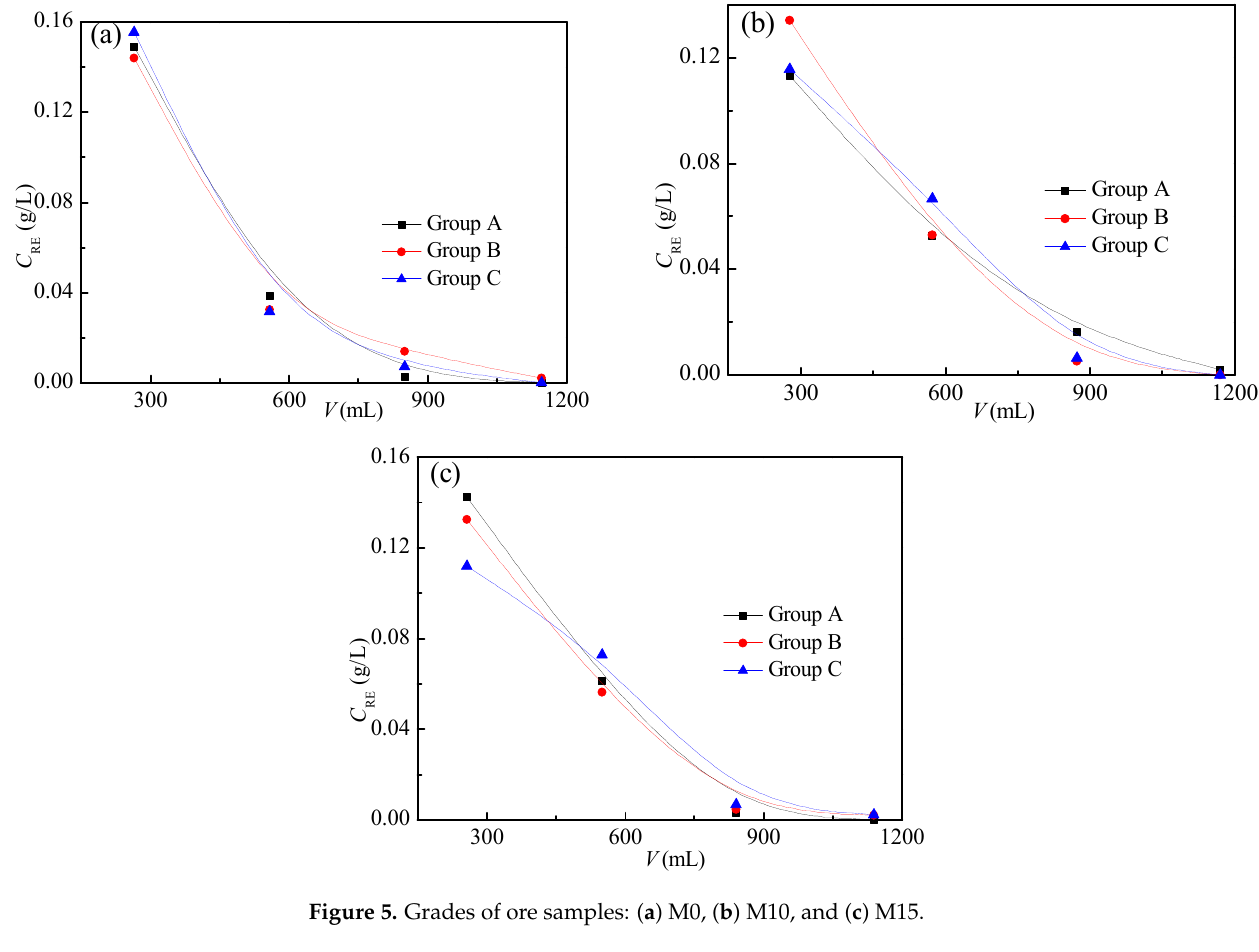
9 of 17 Figure 4. Flow chart of the decoupling method. 4. Results and Discussion 4.1. Relative Molecular Weight and Valence of the Rare-Earth Ions From the distribution data shown in Table 1, the proportions of Y 2 O 3 and Eu 2 O 3 are found to be 0.93% and 17.63%, respectively; this indicates that the test ore samples are of the medium yttrium and rich europium types. Using Equations (1) and (2), the relative molecular masses of the rare-earth ions and rare-earth oxides were calculated to be 135.9 and 331.77 g/mol, respectively. The average valence of the rare-earth ions calculated by Equation (3) is +3.19.